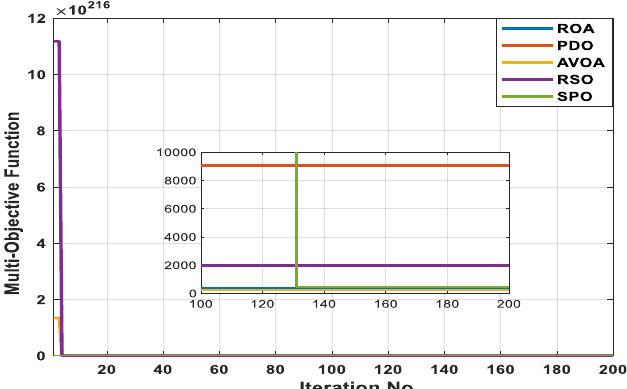
Figure 13. The AVOA convergence characteristics with the other compared methods for case 6.